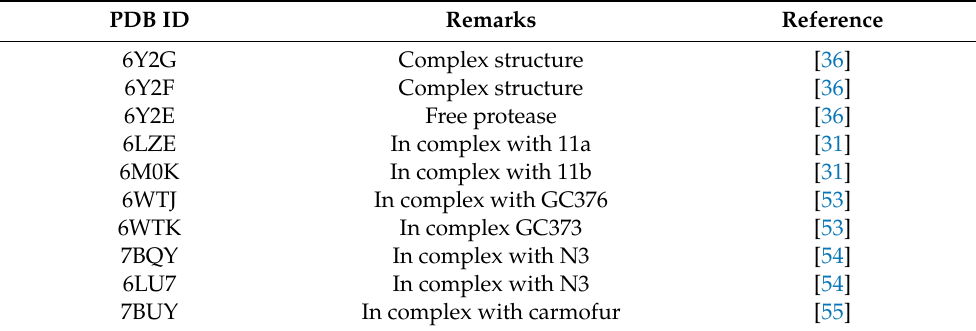
Table 1. Some crystal structures of 3CL pro of SARS-CoV-2 1